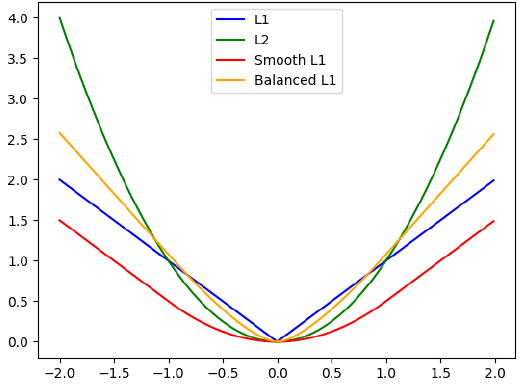
Figure 8. Diagram of several loss